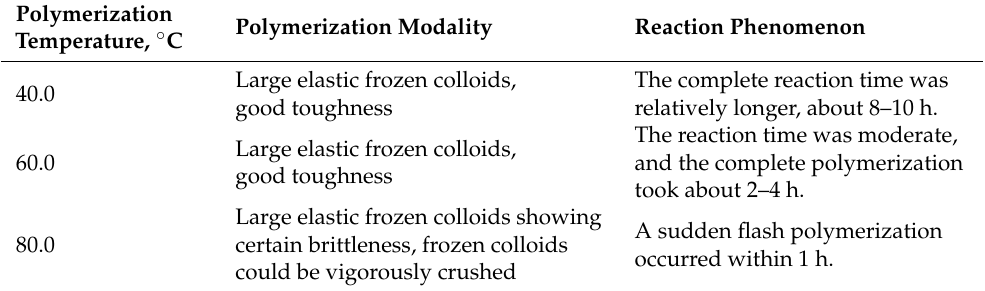
Table 1. Reaction forms at different polymerization